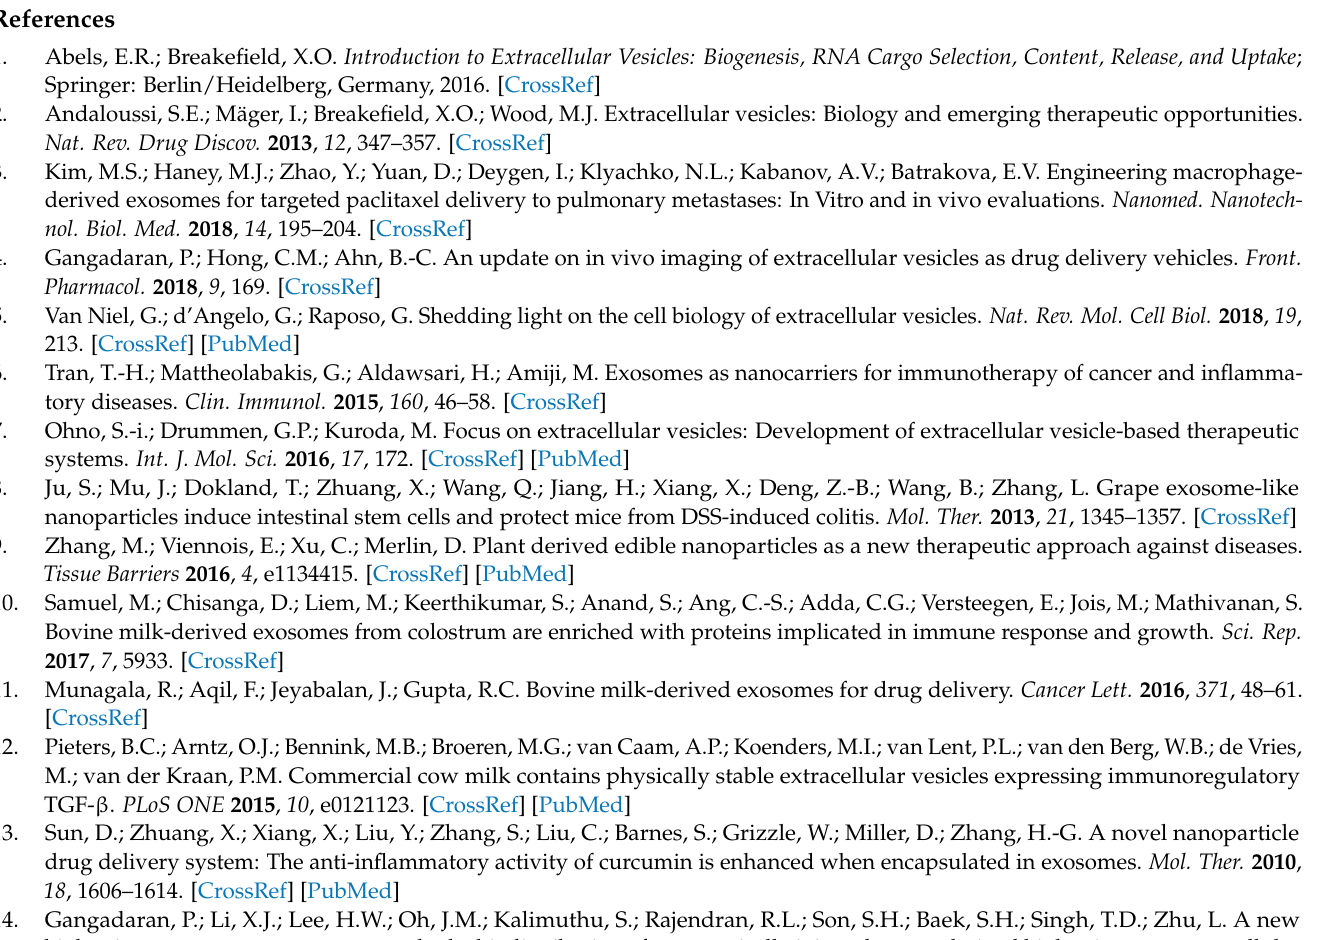
Table S3: Experimental data from Figure 3. In vitro stability of BDP-MiExo evaluated with HPLC; Supplementary Table S4: Experimental data from Figure 4C. Exosome uptake analysis in regions of interest (dose: 5 µ g/mL SCy-MiExo); Supplementary Table S5: Experimental data from Figure 4C. S6: Experimental data from Figure 5B. In vivo average radiant efficiency (%), measured in livers from mice treated with